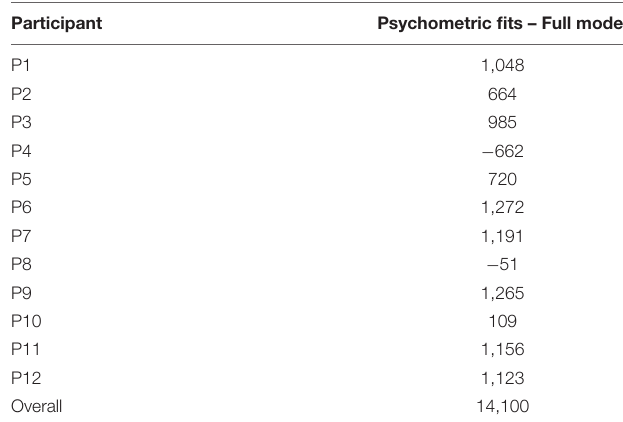
TABLE 1 | Delta BIC values (BIC psy – BIC full